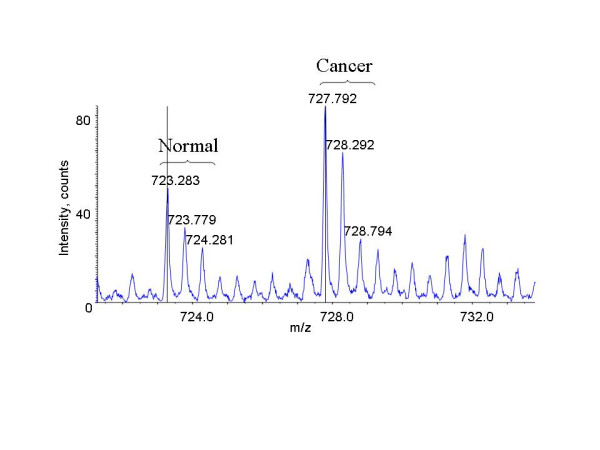
Quantification of vitamin D-binding protein through the ICAT-labeled parent ion signals of the peptide VC*SQYAAYGEK.